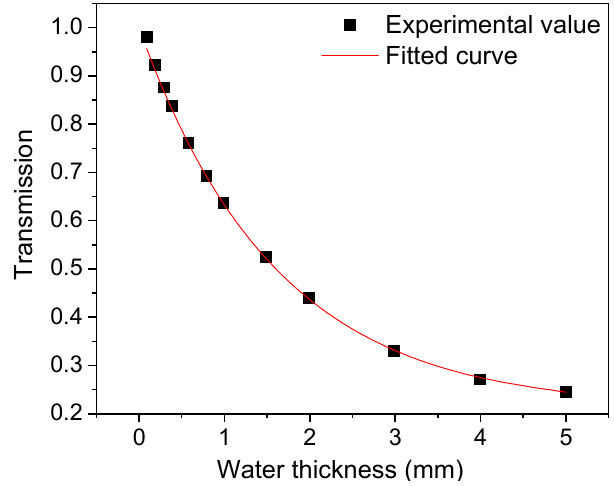
Figure 2 . Calibration curve for water transmission values using different water contents with Figure 2. Calibration curve for water transmission values using di ff erent water contents with standardized thickness. standardized